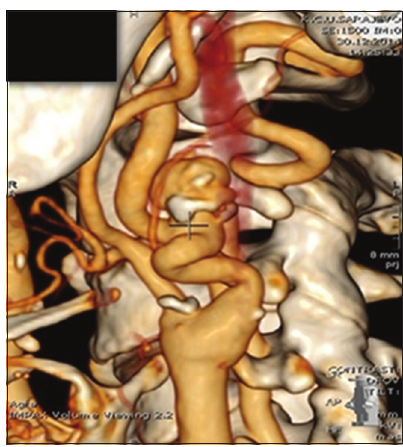
FIGURE 1. Computed tomography angiography (CTA) of the left internal carotid artery (ICA). A berry aneurysm of the left ICA was confirmed by CTA with 3-D reconstructions, which revealed double kinking of the left ICA at 15 mm from the origin, partially thrombosed, and the berry aneurysm measuring 14.2x12.5 mm in diameter, neck widths up to 4 mm. The distal portion of the left ICA preserved a width of circulating